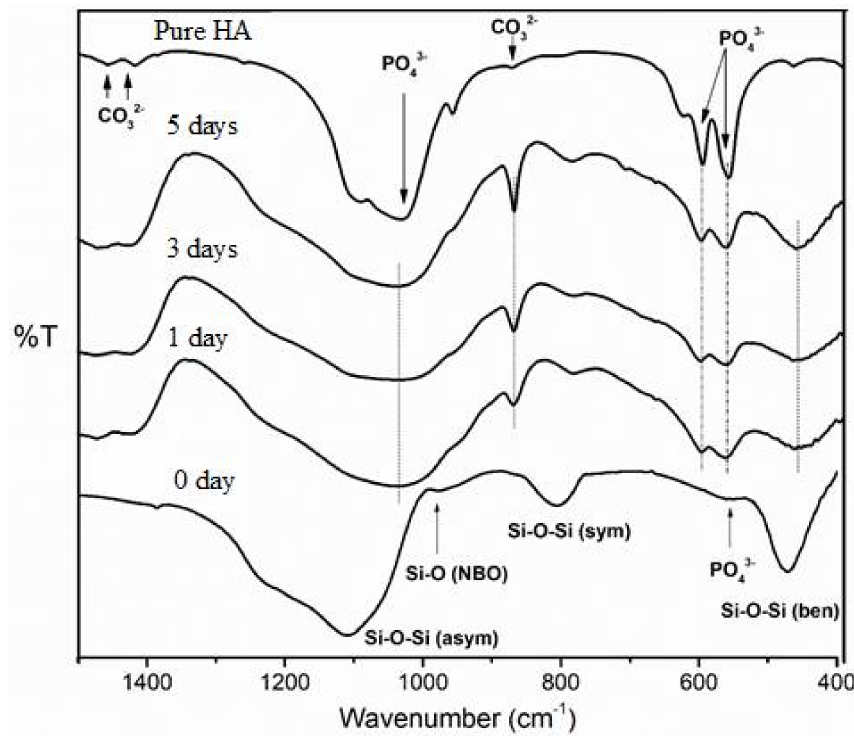
Figure 4. FTIR spectra of bioactive glass before and after the in vitro experiment in the SBF.